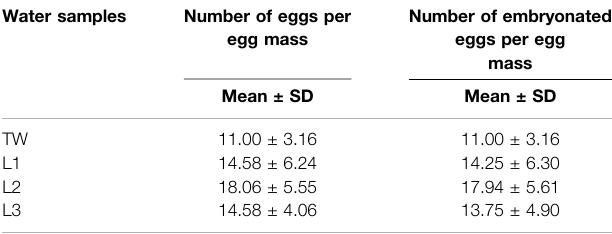
TABLE 3 | Number of Biomphalaria straminea eggs and embryonated eggs per mass. TW: tap water; L1, L2, and L3: samples sites, Lugano Lake. No signi fi cant differences between treatments were observed (ANOVA, p > 0.05).